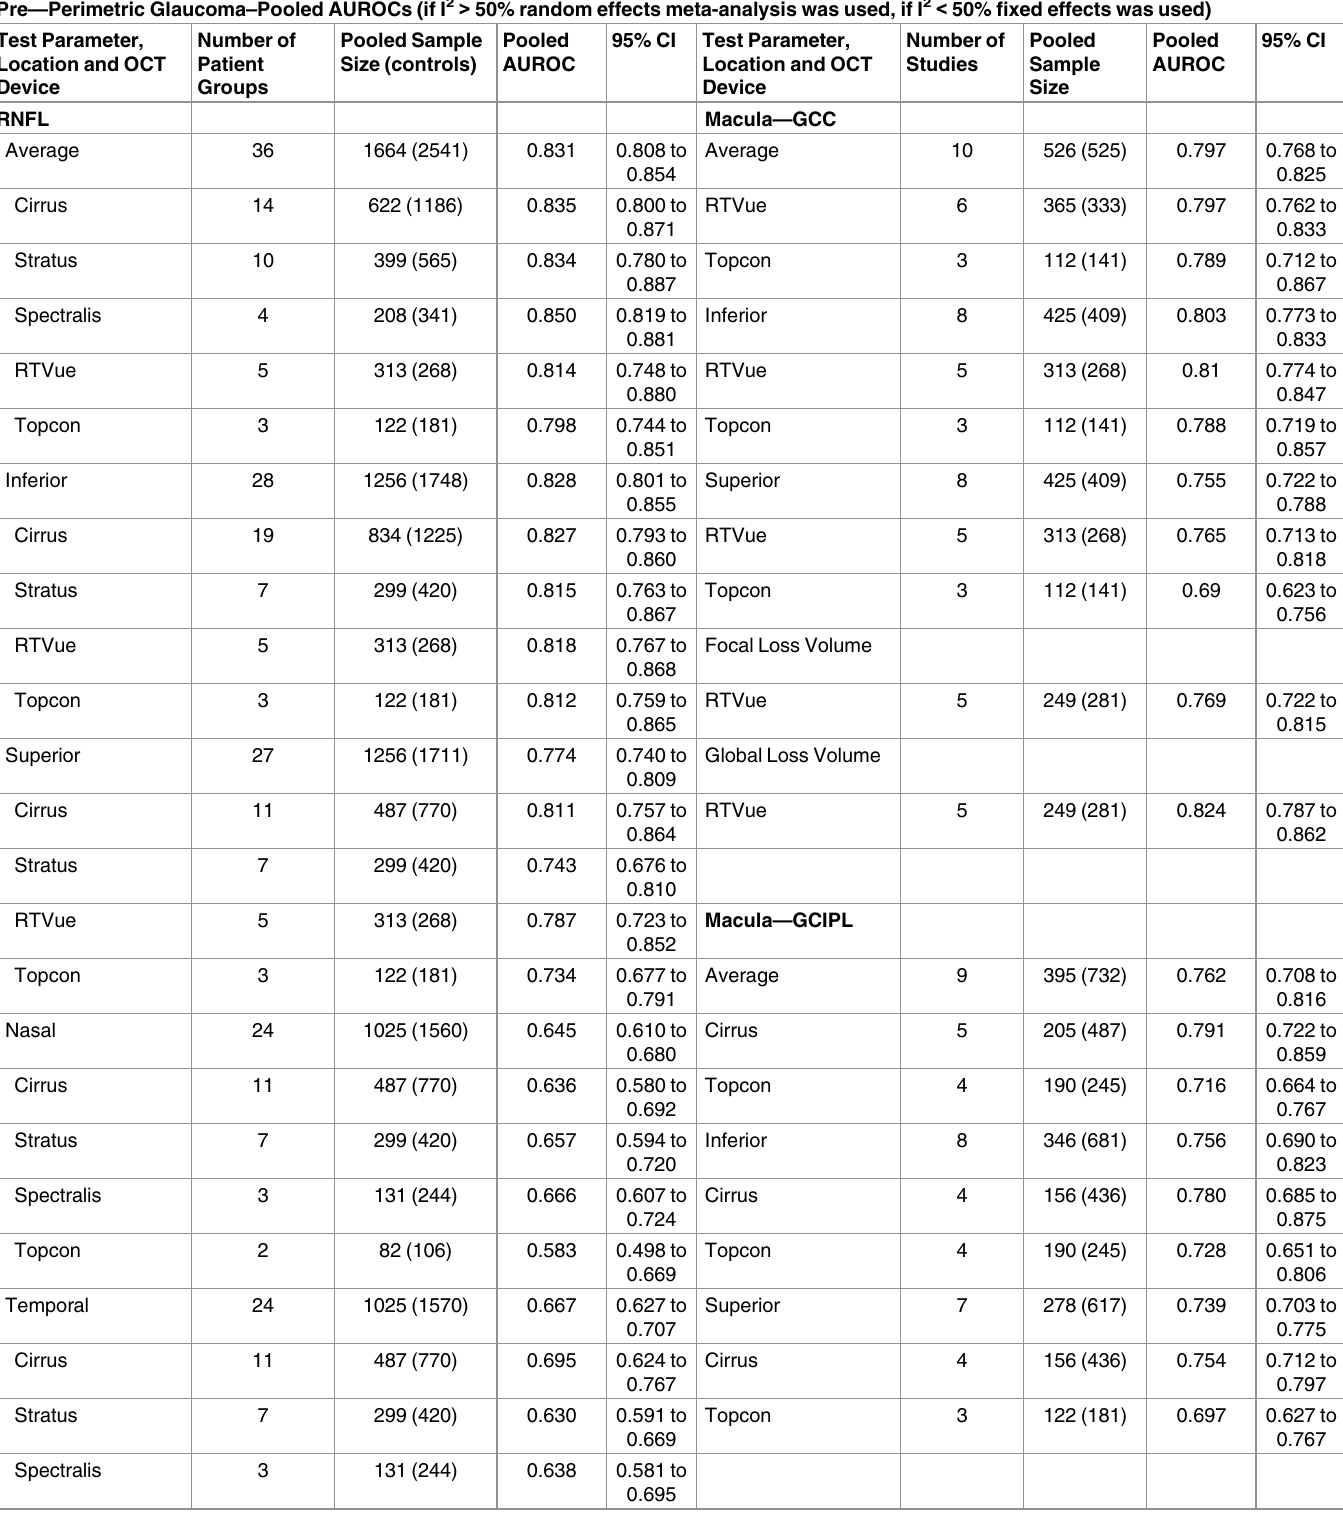
Table 4. Pooled AUROCs of RNFL and macular OCT parameters for pre-perimetric glaucoma